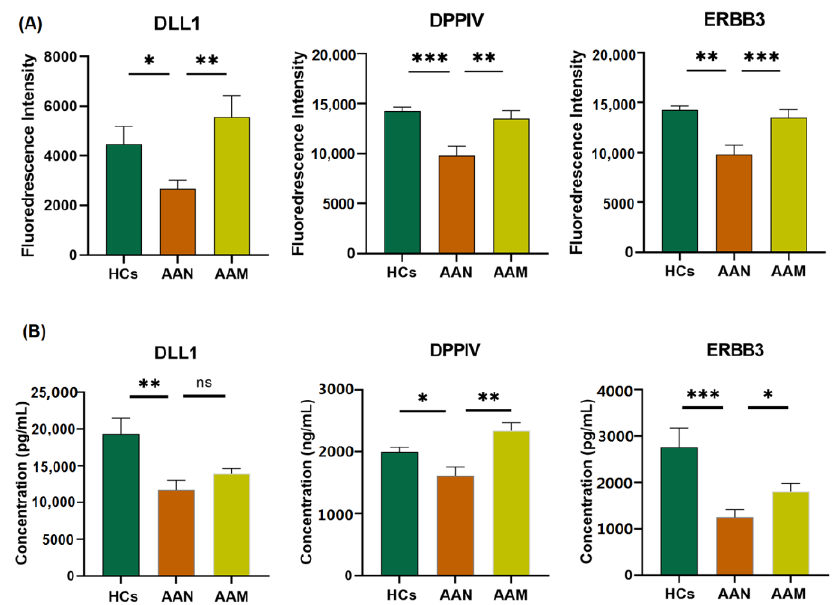
Figure 4. Exploration of crucial proteins among AAM and AAN patients and healthy controls. ( A ) Protein array results; ( B ) ELISA results in validation cohort 2. Data represent mean ± standard error. One-way ANOVA followed by multiple comparisons was conducted to examine the differences among the three groups. * p < 0.05, ** p < 0.01, *** p < 0.001. DLL1: delta-like protein 1, DPPIV: dipeptidyl peptidase 4, ERBB3: receptor tyrosine-protein kinase erbB-3.